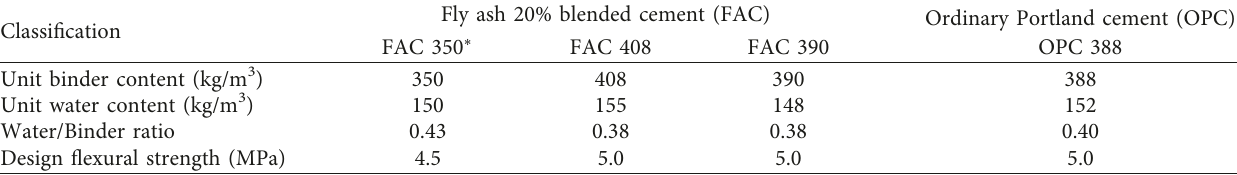
Table 8: Experimental constructions to improve standard mix design of concrete pavement.